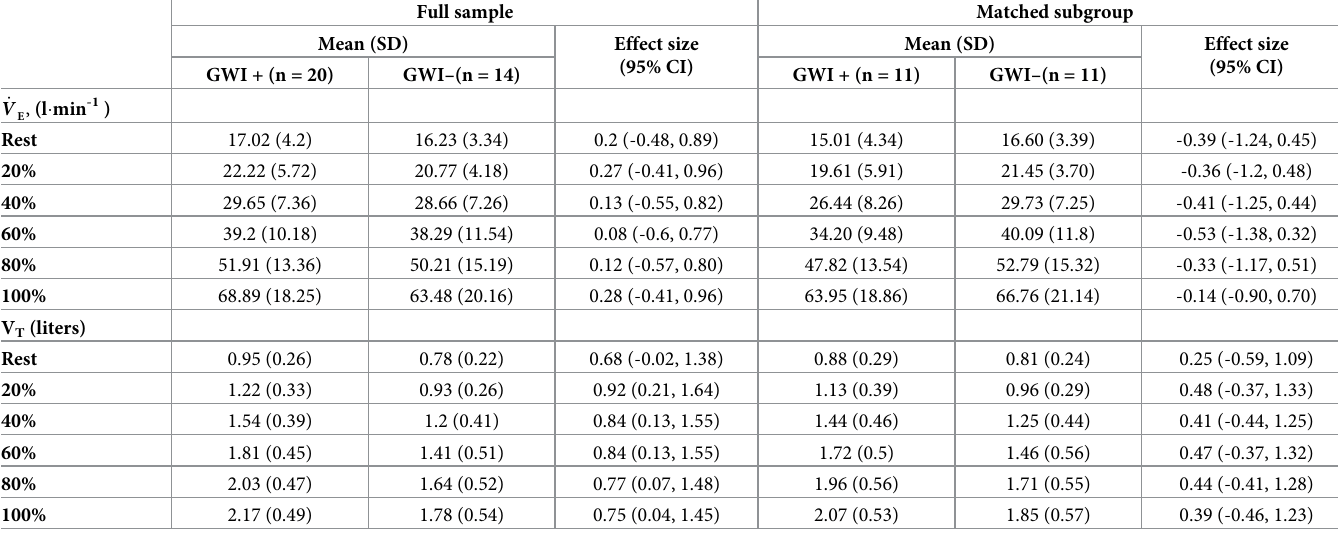
Table 5. Comparison of mean (SD) ventilatory patterns between participants with positive and negative Gulf War Illness